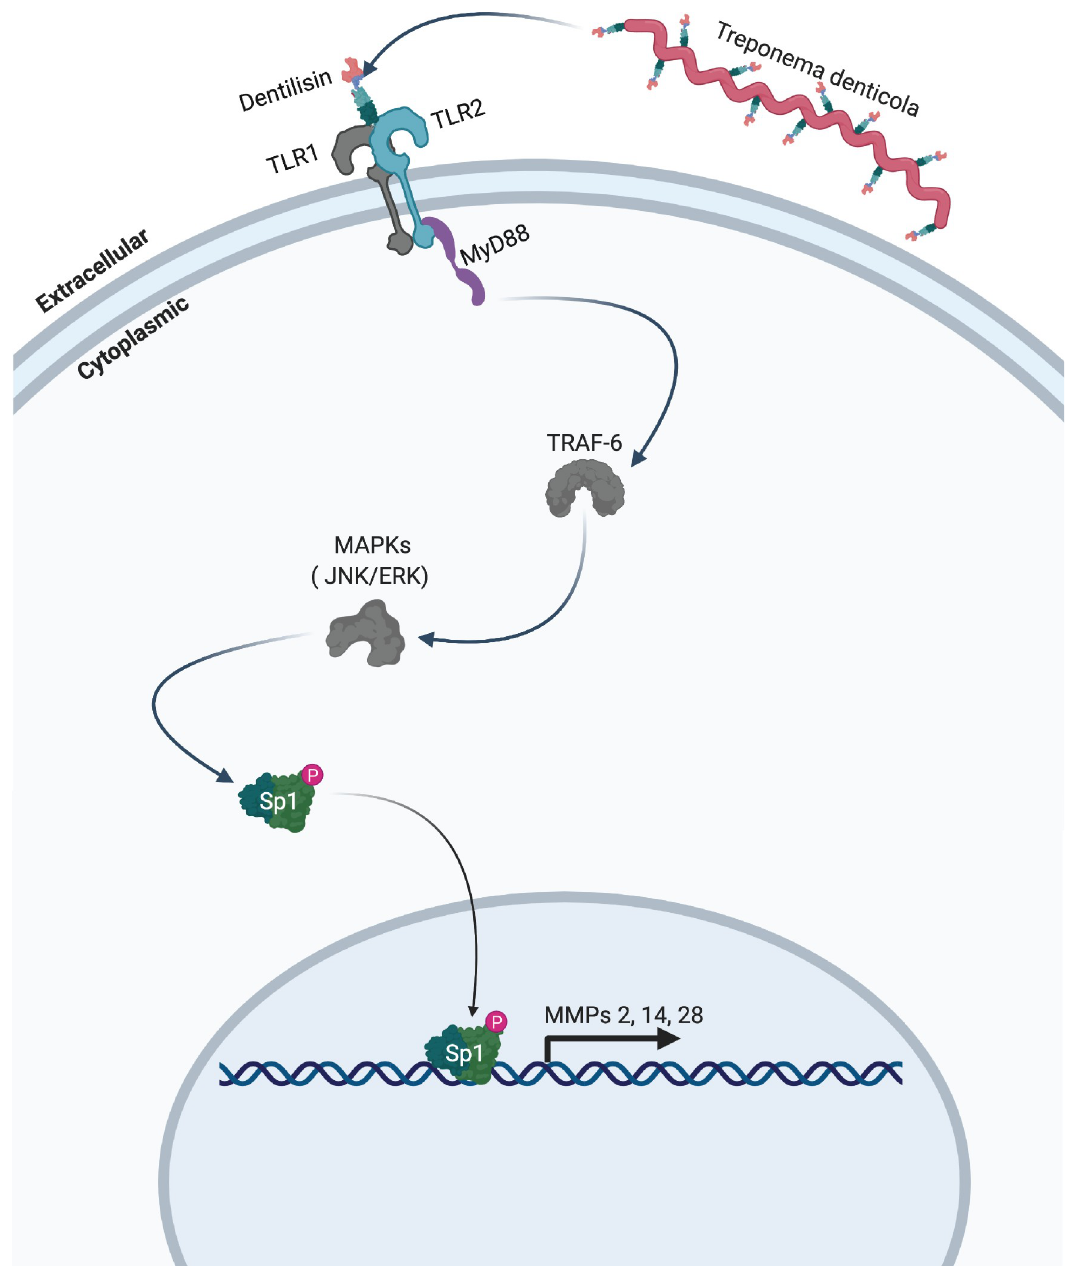
Fig 10. Model of proposed mechanism. T . denticola activates host expressed TLR2 receptors via surface-expressed dentilisin. Subsequent downstream activation of MyD88 and translocation of the transcription factor Sp1 lead to the upregulation of MMPs 2, 11, 14, 17 and 28 in human periodontal ligament cells. Grey colored icons represent genes that were identified through RNA- sequencing and analysis but were not directly validated.